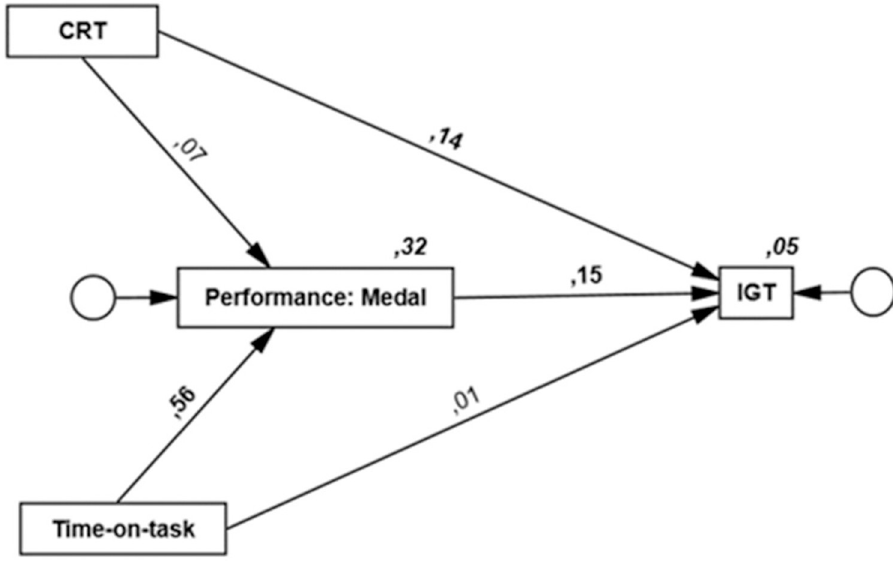
Fig 1. Path model with Iowa Gambling Task (IGT) regressed on Medal, cognitive reflection task (CRT), and Time-on-task. Digits on bold represent significant standardized regression weights. Digits in italics show squared multiple